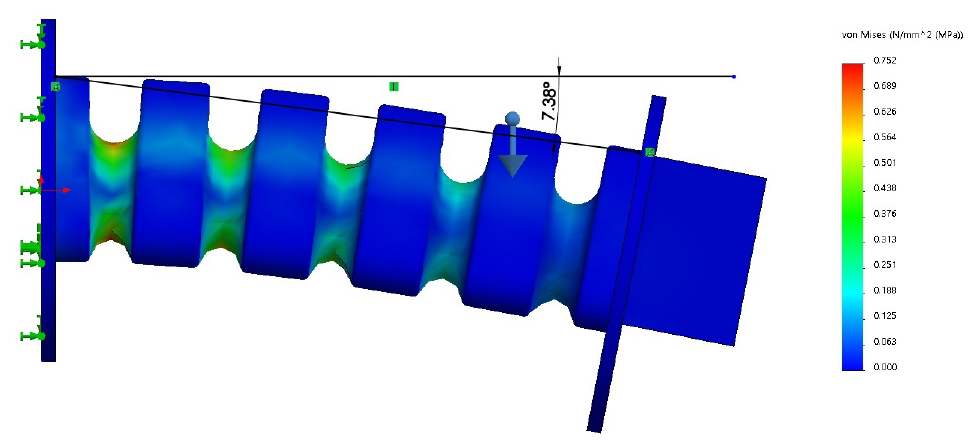
Figure 8. Simulation of soft joint with a 500 g prism and a 10 N downward force at the free